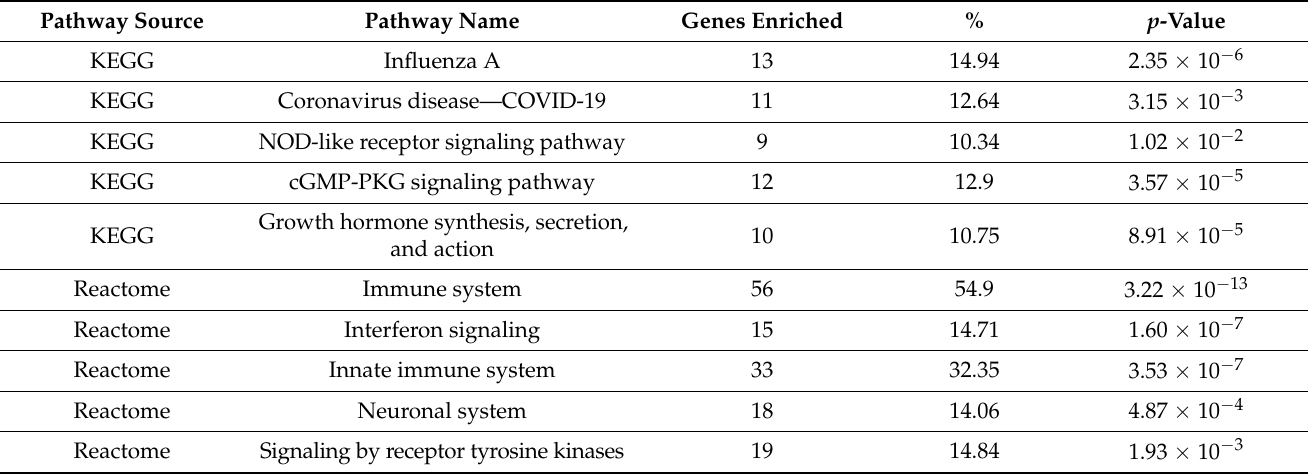
Table 2. KEGG and Reactome pathway analysis of the differentially expressed genes associated with SARS_CoV-2–GBM